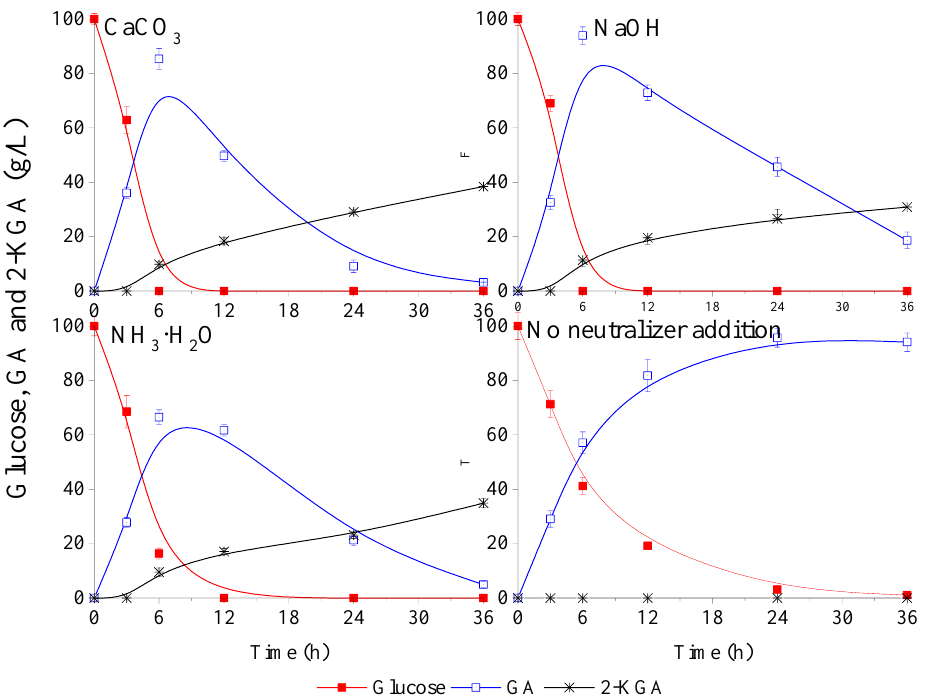
Figure 1. Effect of pH neutralizers on the glucose metabolism kinetics of Gluconobacter oxydans (GA: gluconic acid; 2-KGA: 2-ketogluconic acid). Three different prevalent neutralizers were chosen: CaCO 3 , NaOH, NH 3 · H 2 O. The blank control was no neutralizer addition (none).